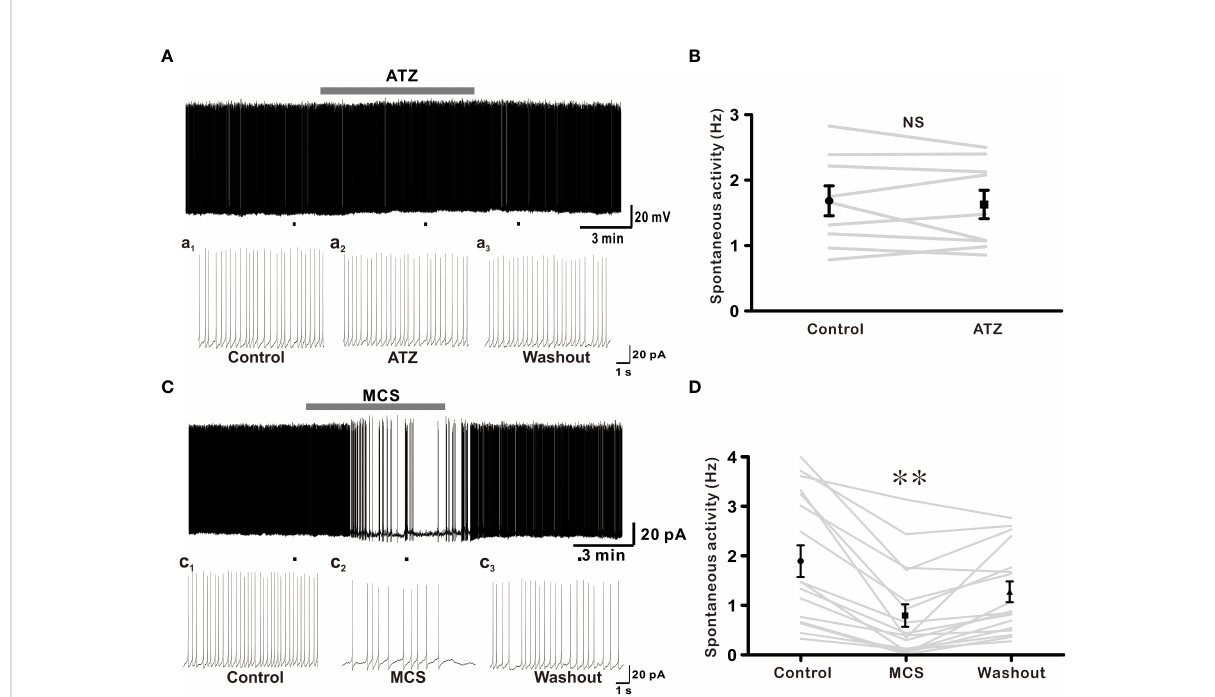
FIGURE 6 Glutathione peroxidase (GPx) inhibition suppresses excitability of GnRH neurons. (A) A representative current-clamp trace showing no effect of 1 mM ATZ (catalase inhibitor) on GnRH neurons. (C) A typical current-clamp trace showing a decrease of spontaneous activity of GnRH neurons after perfusion with 1 mM MCS, a GPx inhibitor. (B, D) Before and after plot showing effects of ATZ and MCS on mean spontaneous fi ring of GnRH neurons, respectively (** p < 0.01; one-way